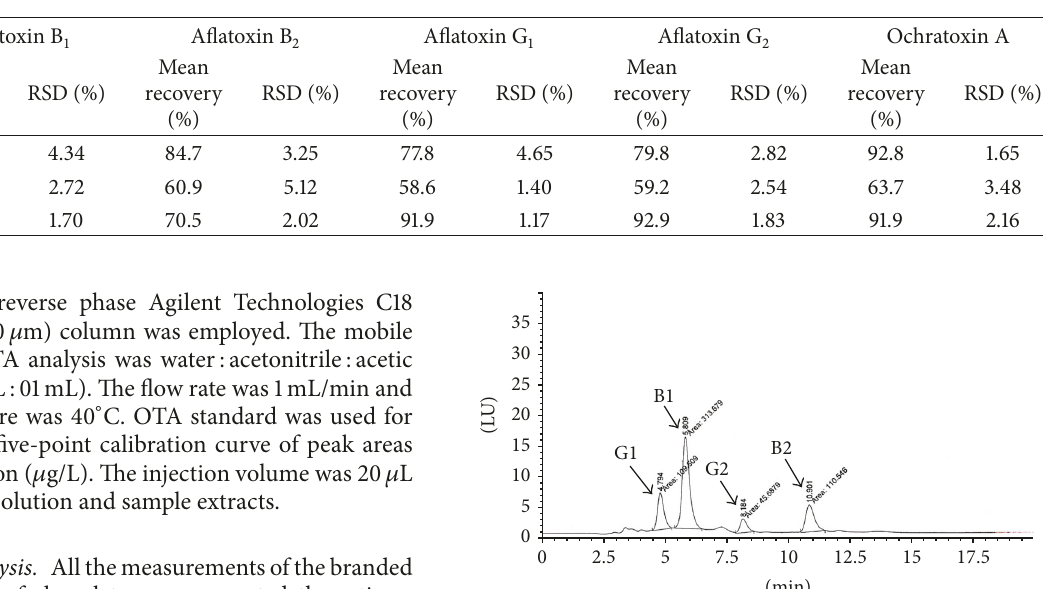
Table 1: Recoveries of mycotoxins from spiked chocolates.